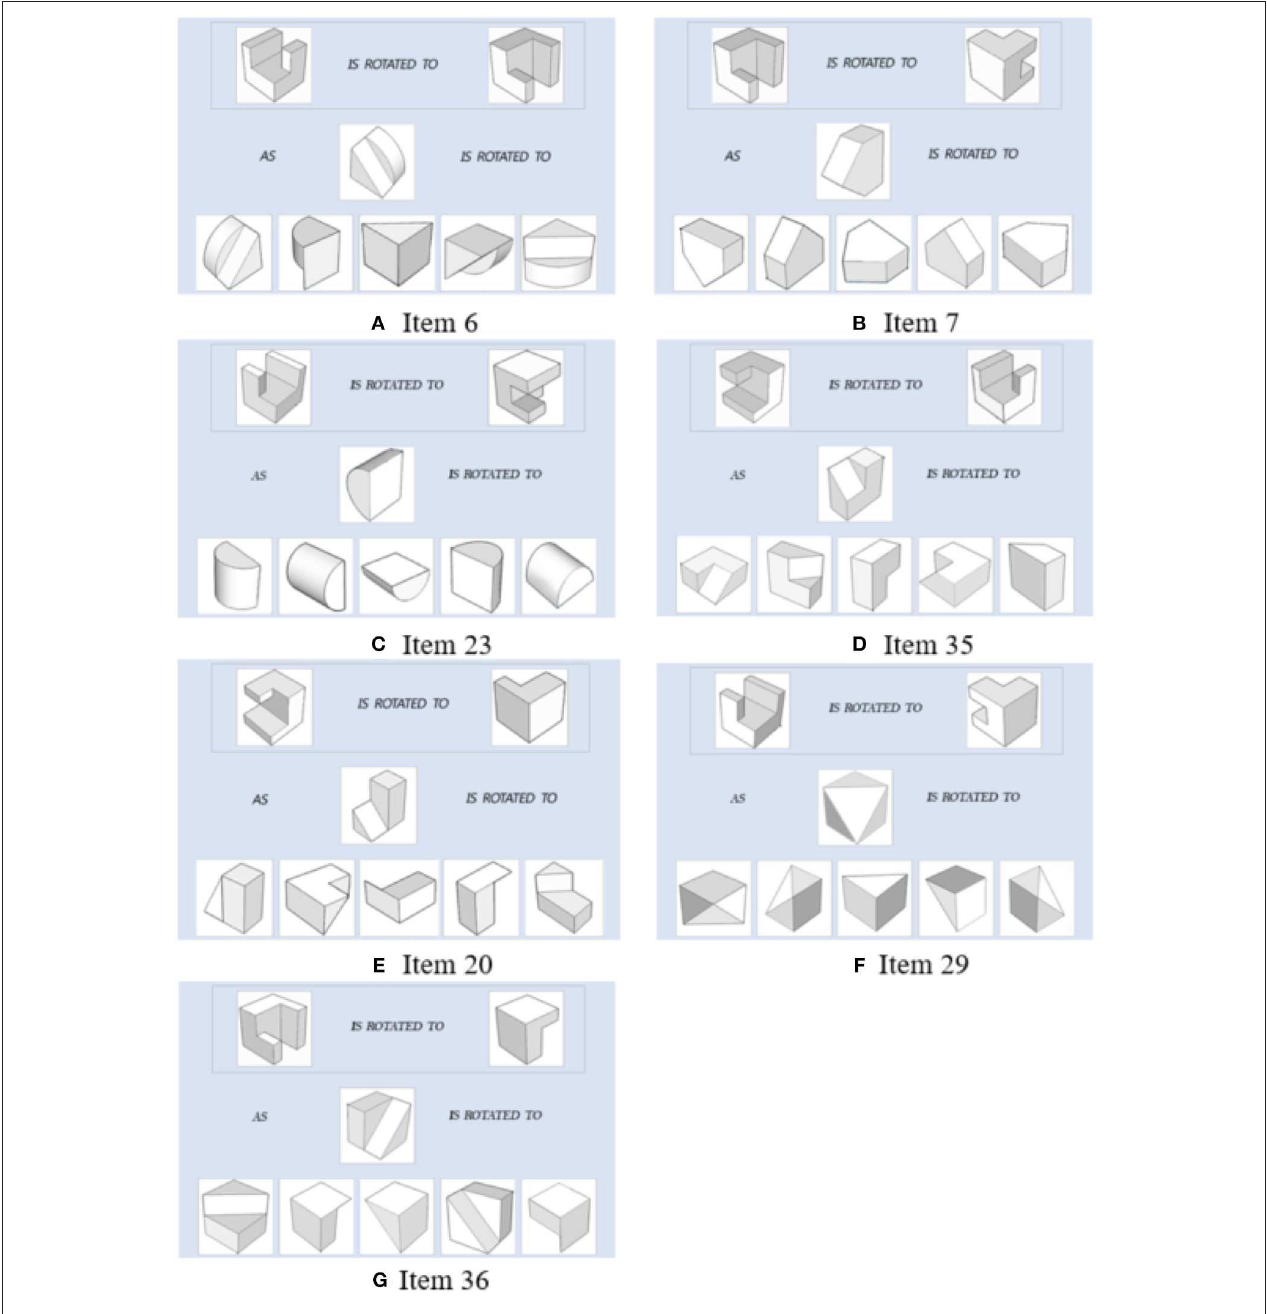
FIGURE 5 | Items measuring x 90 and y 90. Items 6,7,23, and 35 are clustered with simple items. Items 20, 29, and 36 are clustered with other complex items.